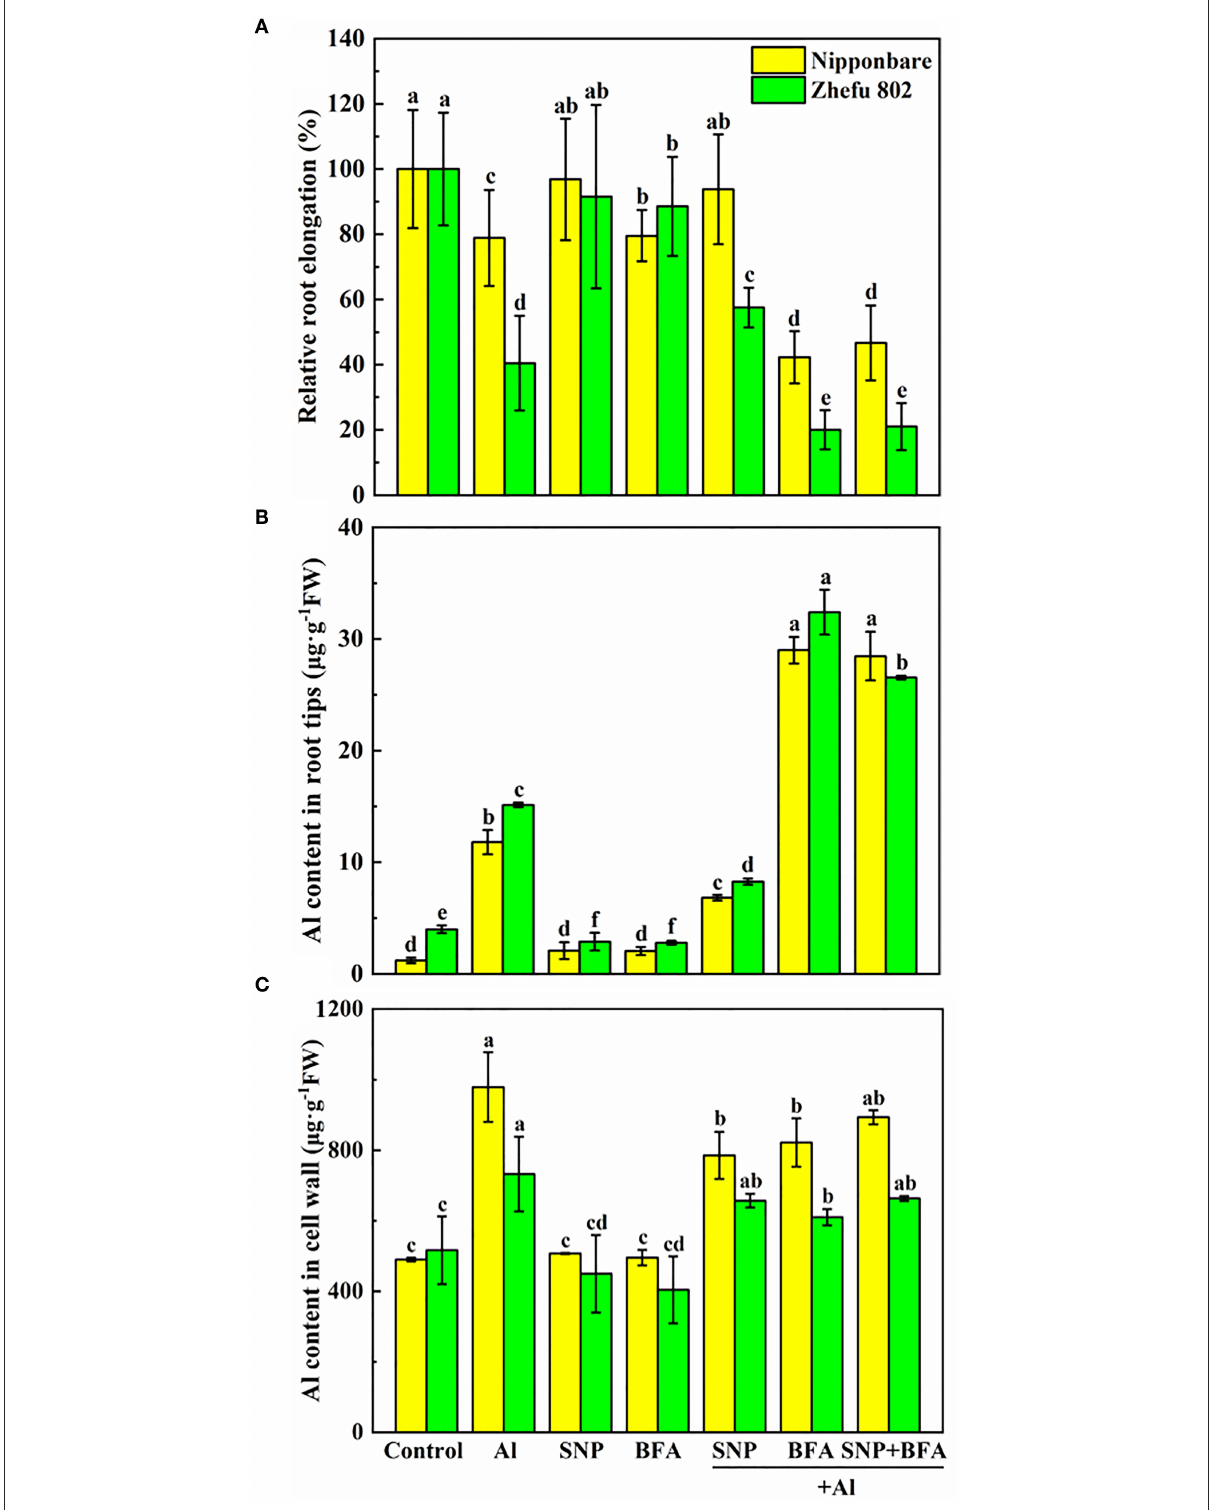
FIGURE4 Effect of BFA and SNP on (A) rice root growth, (B) Al content in rice root tips, and (C) cell wall Al content. Columns with different letters are significantly different at P < 0.05 .